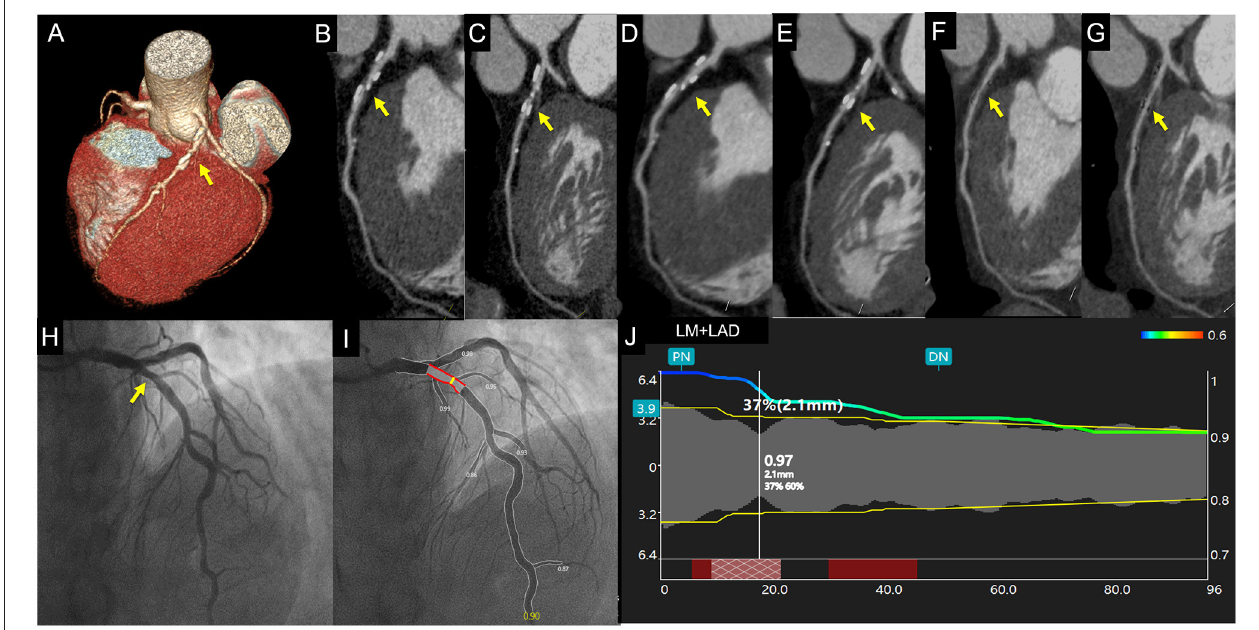
FIGURE 3 | Case 2. A 67-year-old asymptomatic patient. Volume rendering and curved multiplanar reformation of traditional CTA HLR (A–C) images show about 65% stenosis of a proximal left anterior descending coronary artery caused by calcified plaque. CTA DLR (D,E) images show superior image quality yet a similar degree of stenosis. CTA sDLR images of corresponding position (F,G) show mild stenosis (40%). Invasive coronary angiography (H) and quantitative coronary angiography (I,J) confirm the stenosis degree of 37%. Written informed consent was obtained from the individual for the publication of any potentially identifiable images or data included in this article. The yellow arrow shows the location of coronary